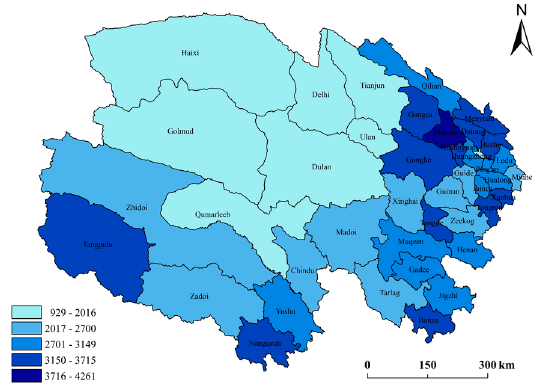
Figure 3. Ecological service value per unit area of each town (city) in Qinghai Province in 1988 (yuan/hm 2 ).